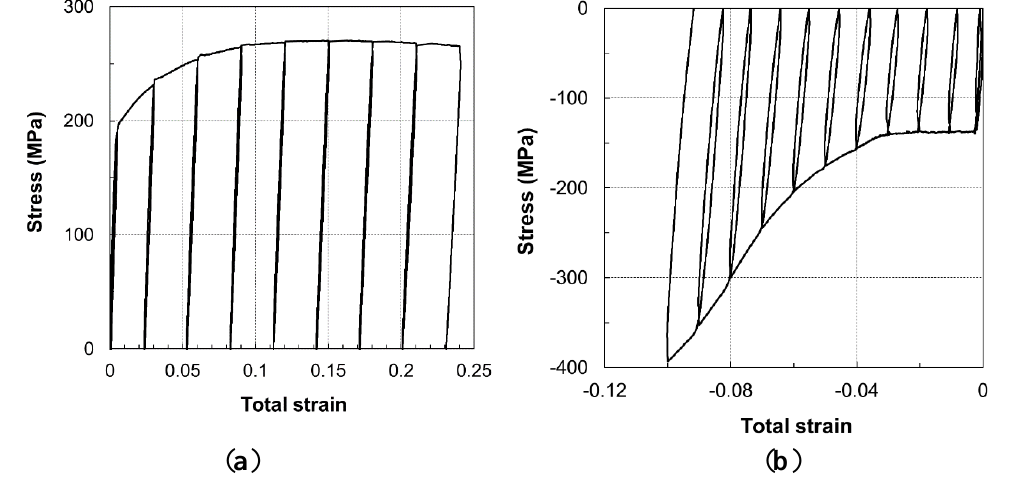
Figure 10. Stress-strain curve in the loading-unloading-reloading tests at RT for: ( a ) tension and ( b ) compression